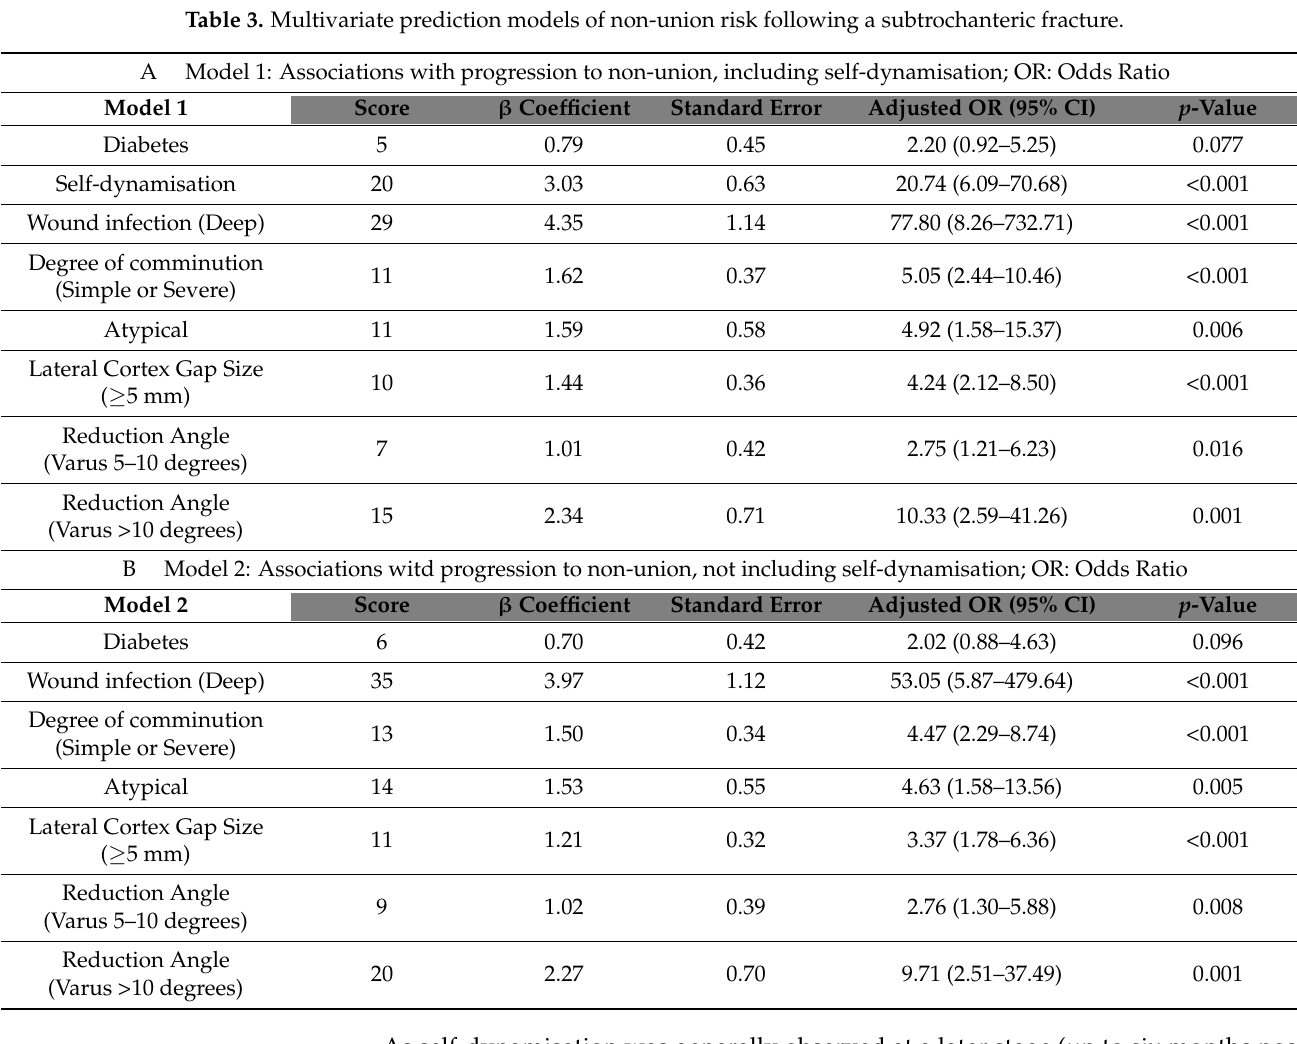
Table 3. Multivariate prediction models of non-union risk following a subtrochanteric